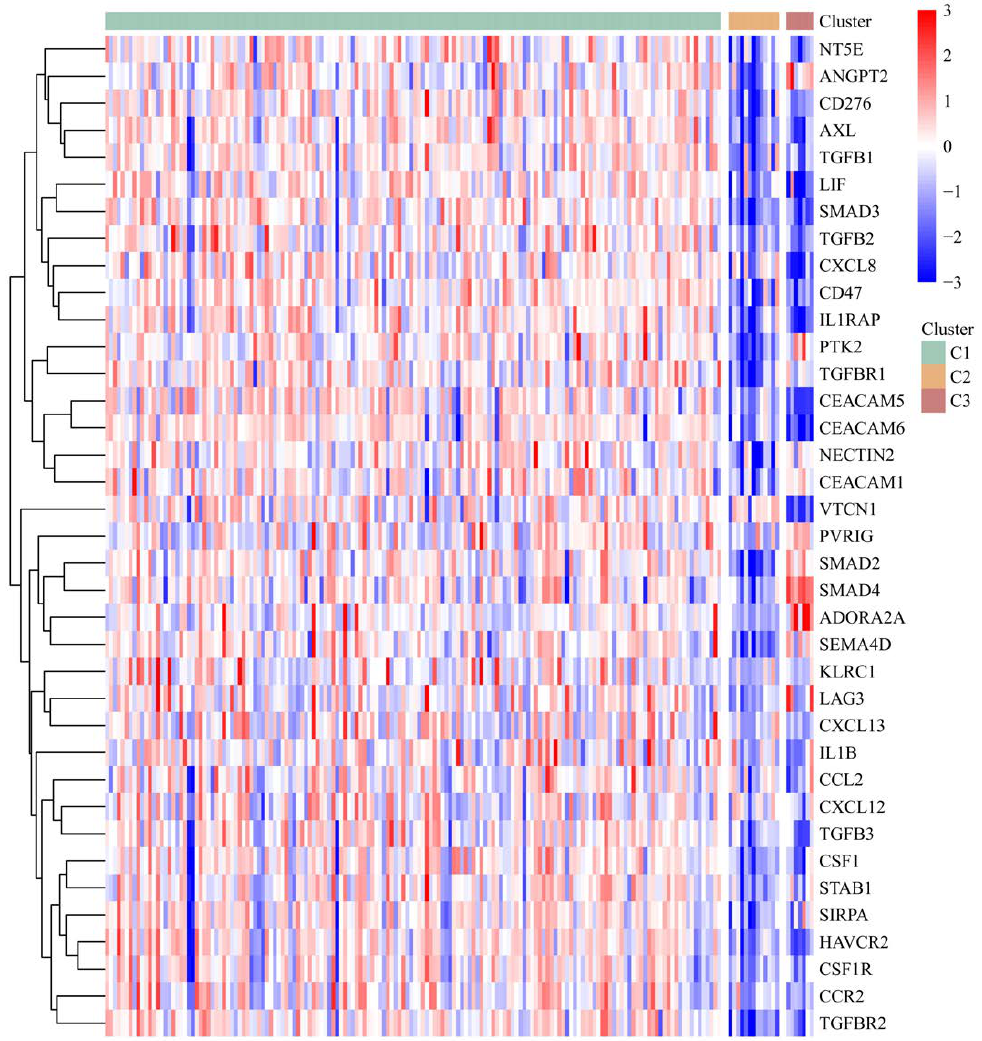
Figure 8. The heatmap displays the expression of the representative genes of the currently FDA- approved immune checkpoints in different IRGPI-based molecular subtypes. The x -axis represents the TCGA samples involved in the analysis. The red color indicates a positive correlation, while the blue color indicates the opposite.